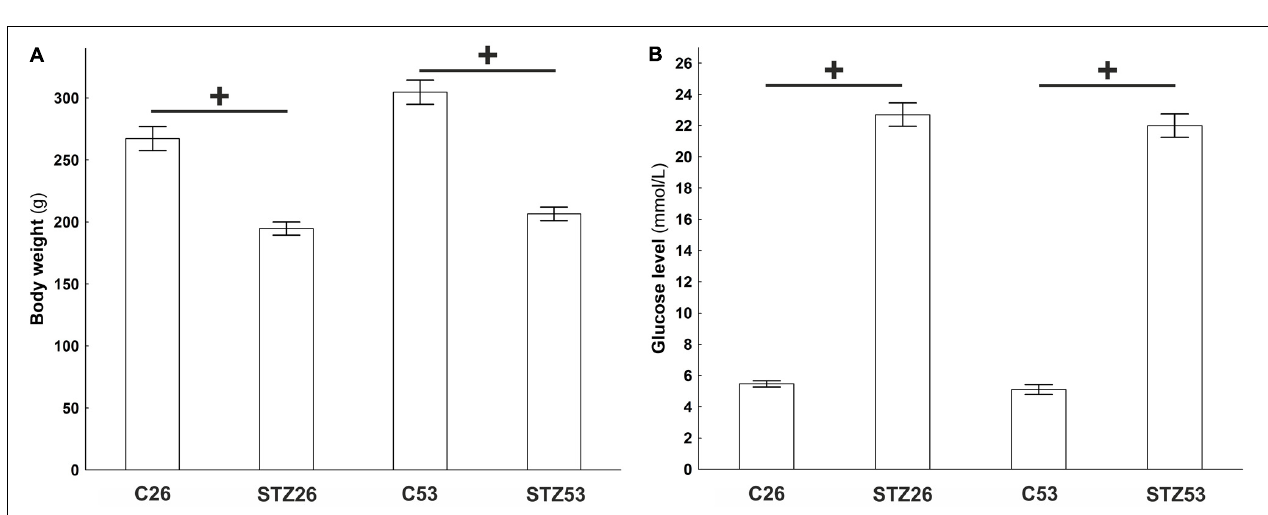
FIGURE 8 | Body weight (A) and plasma glucose (B) of controls (C) and streptozotocin (STZ) treated animals measured in two time points, 26 and 53 weeks after the induction of diabetes. Data are presented as means ± SEMs. + p < 0.0001. N =